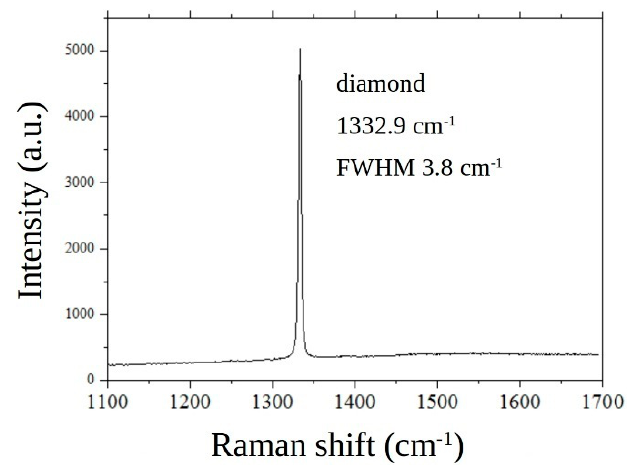
Figure 5. Raman spectrum taken on the growth side of a membrane. The sharp peak at 1332.9 cm − 1 is associated to diamond.